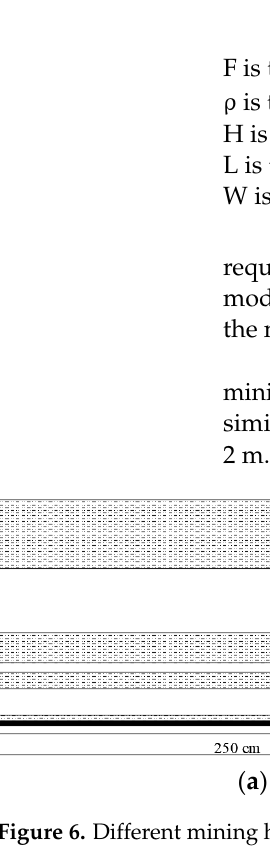
Figure 8. Mining and backfilling process in the physical model: ( a ) 2 cm mining height; ( b ) 4 cm mining height. To study the control effect of overburden subsidence in pier ‐ column backfilling, it is necessary to observe strata movement. In this experiment, a DigiMetric 3D photogram ‐ metric system (with a precision of less than 0.1 mm/4 m) was adopted to measure the